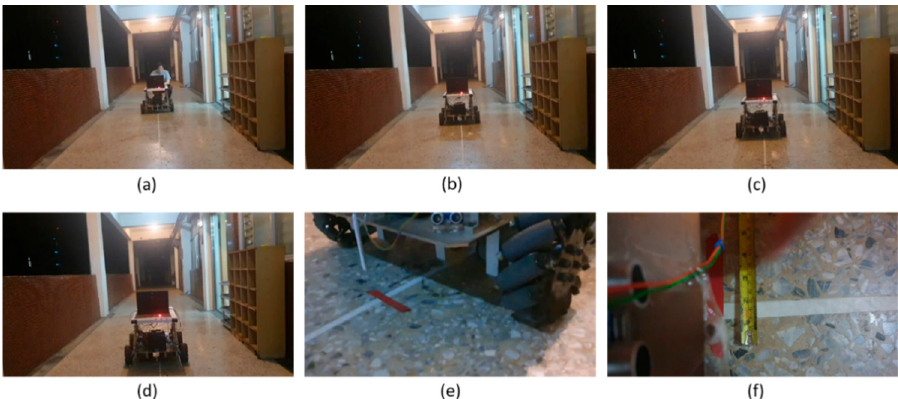
Figure 16. OMWAGV walking straight 400 cm with RLS estimation compensation. ( a ) Starting po- sition, ( b – e ) at middle way, and ( f ) deviation at stop position.